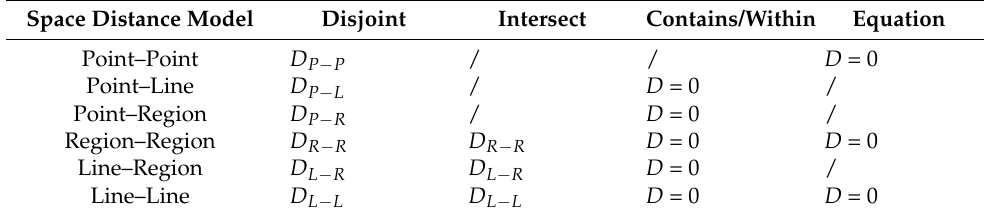
Table 1. Computational framework for calculating the spatial similarity of geo-entities.